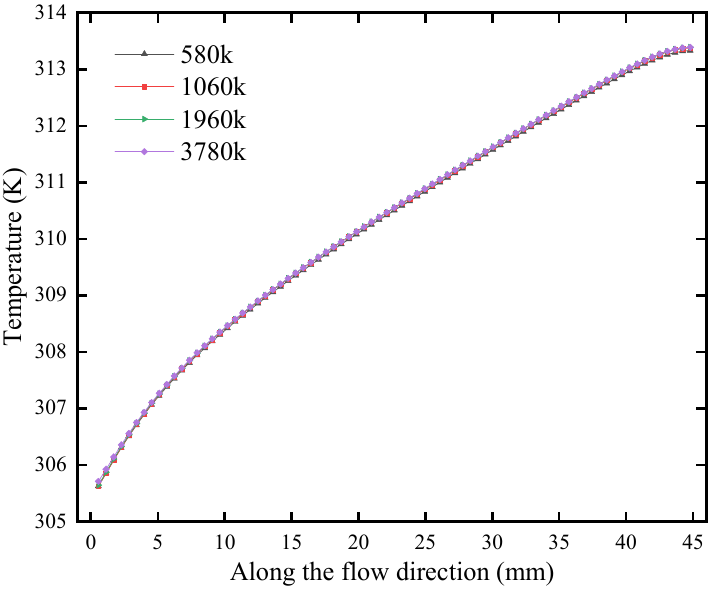
Figure 2. Simulation results using different number of grids.